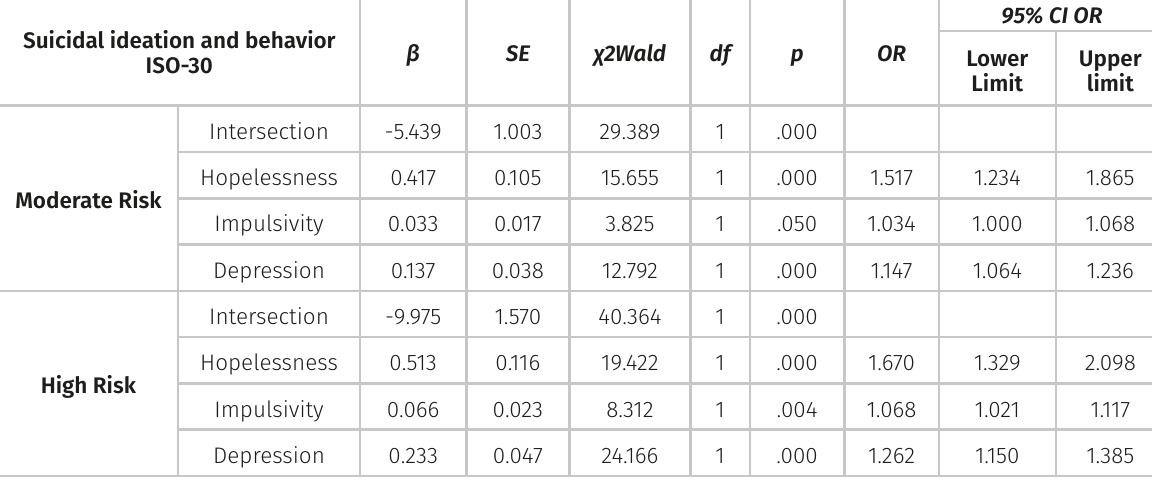
Table III. Multinomial logistic regression analysis. Suicidal ideation and behavior